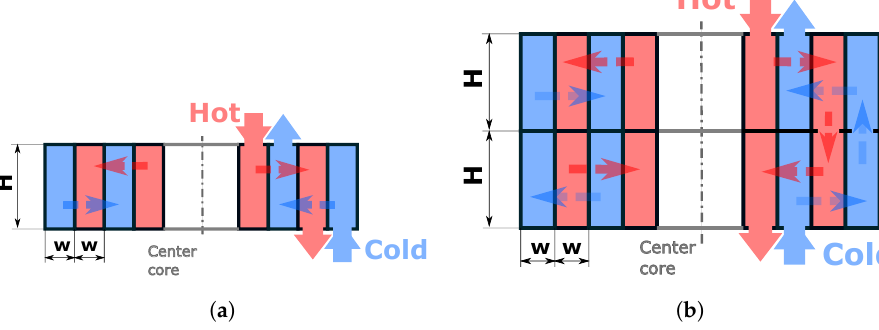
Figure 1. Schematic configurations of SPHE: ( a ) Single module SPHE. ( b ) Two-module SPHE. The heat exchanging spiral walls are configured such that the stream channels start and end at the same angle, thus producing the same number of turns, as shown in Figure 2.